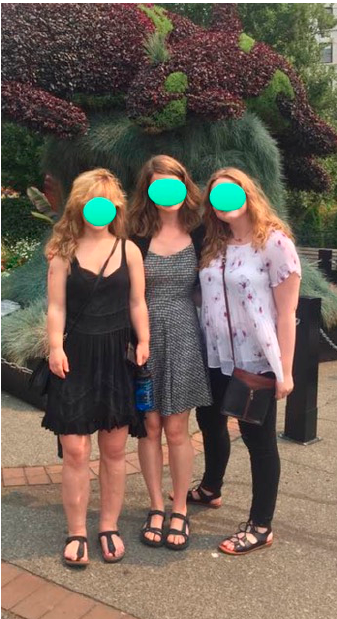
Figure 6. Same patient as in Figures 4 and 5 standing to the right of both of her friends (left side of picture), all of whom are of normal height.